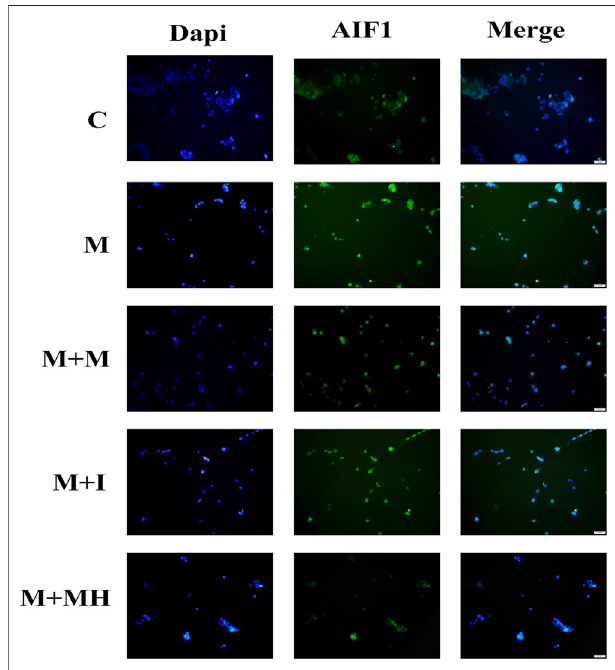
FIGURE 2 | Cells were subjected to immuno fl uorescence analysis using an antibody directed against AIF1 (green). Nuclei were counterstained with DAPI (blue). The fl uorescence was visualized and imaged under a fl uorescence microscope. C: control group; M: morphine group; M + M: morphine+methadone group; M + I: morphine+isorhynchophylline; M + MH: morphine+minocycline